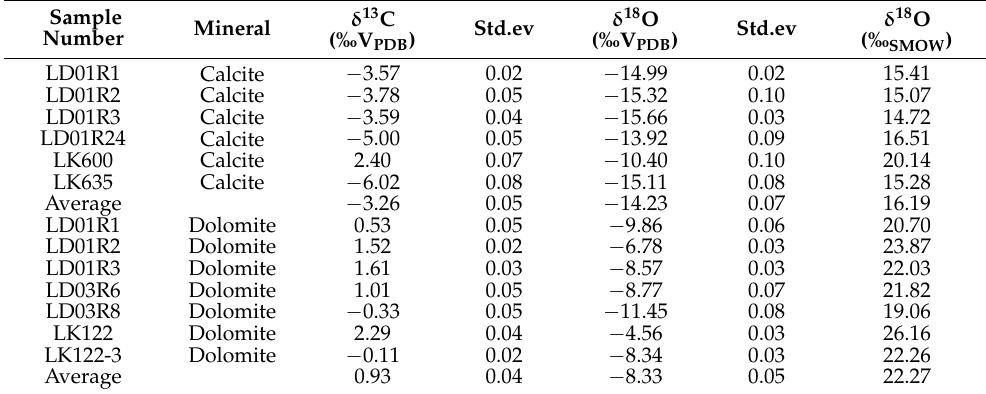
Table 2. C-O isotopic composition of hydrothermal calcite/dolomite in Lekai Pb-Zn